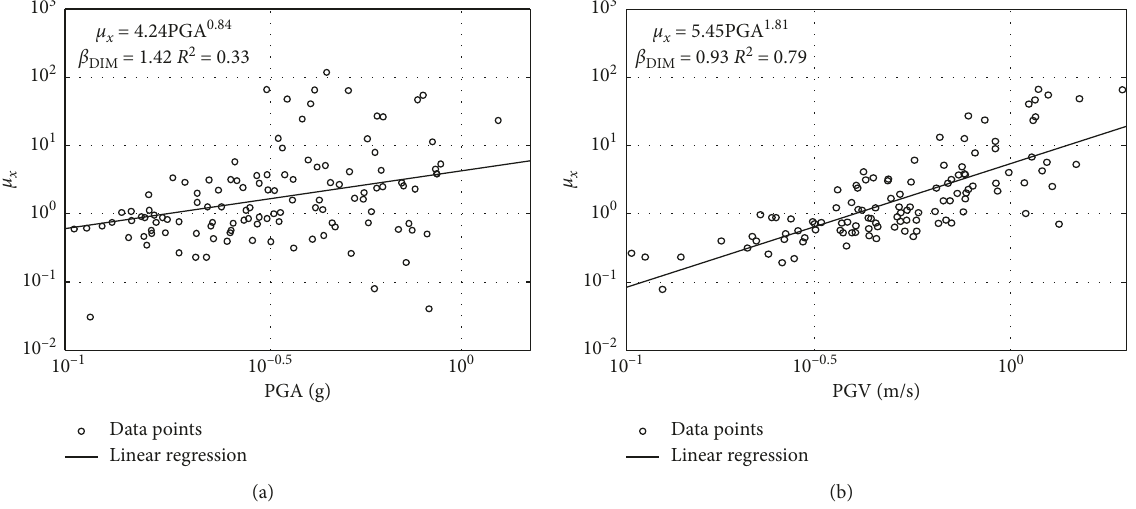
Figure 5: PSDMs for the curvature ductility demand μ